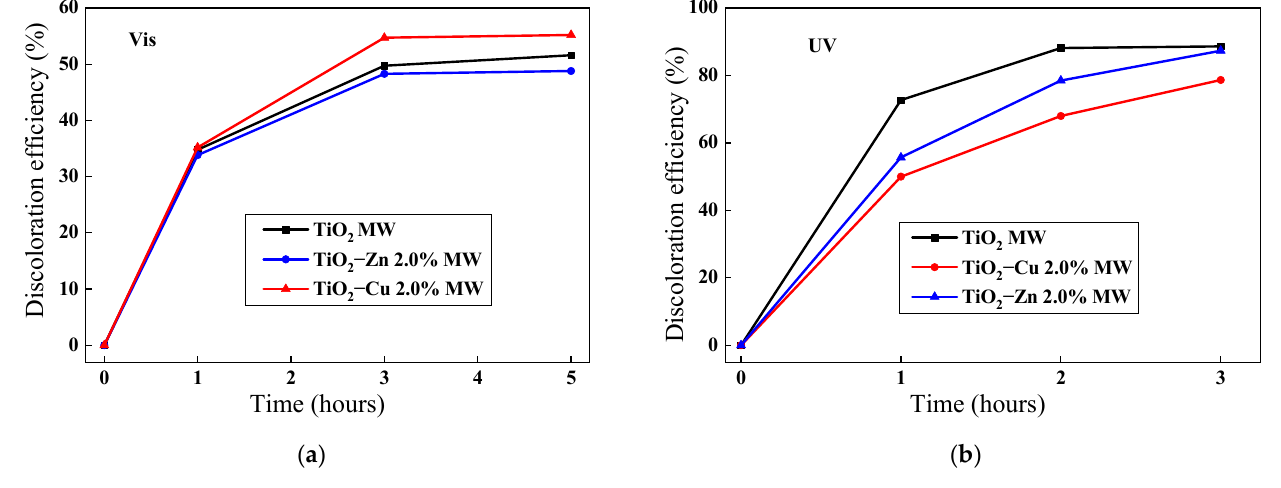
Figure 16. Photoluminescence spectra of doped and undoped TiO 2 nanopowders ( λ exc = 320 nm).